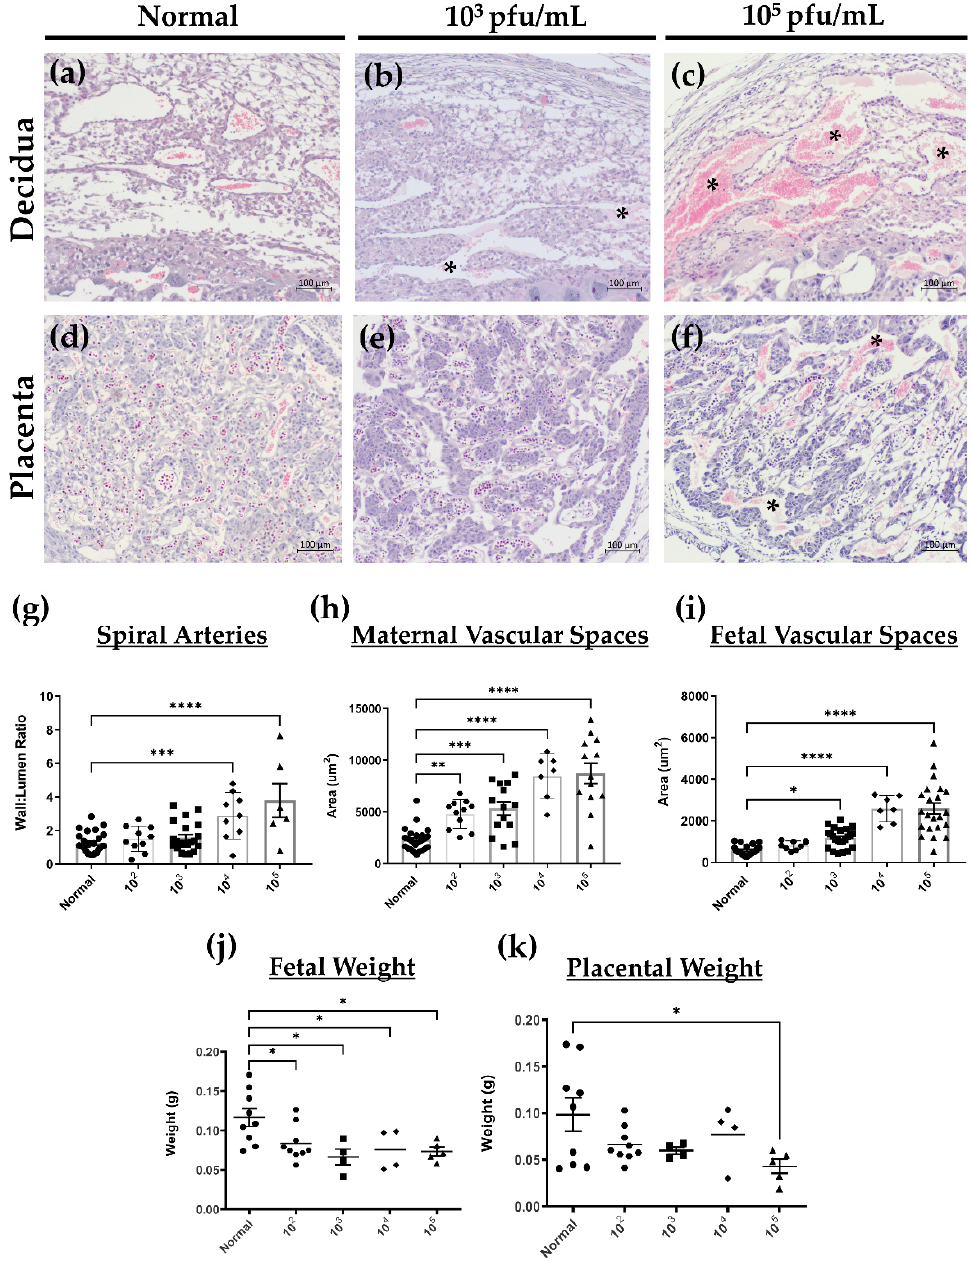
Figure 6. HSV-2 infection compromises tissue integrity and vascular remodeling resulting in de- creased fetal growth at gd12.5. ( a ) H&E staining of decidua from normal mice at gd12.5. ( b ) Decidua from mice infected with low dose HSV-2 (10 3 pfu/mL) showed signs of hemorrhage and necrosis